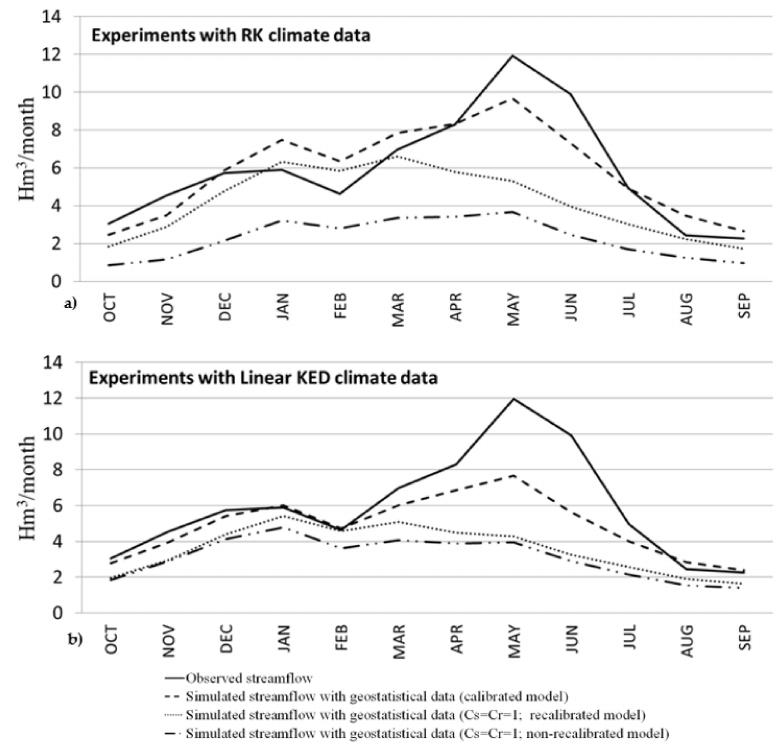
Figure 9. Monthly mean streamflow series for the six approaches against the observed data: ( a ) RK model; ( b ) linear KED model.